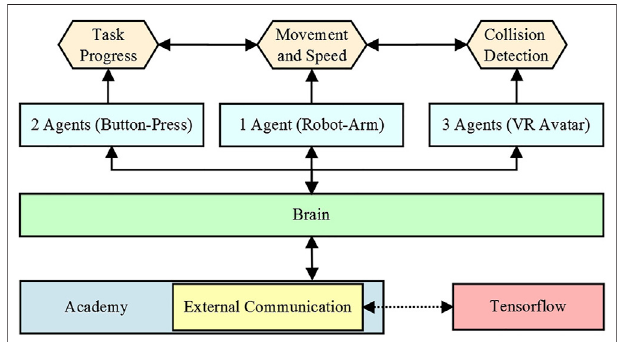
FIGURE 5 | The schematics of the ML-Agents framework consisted of three components, the agents, the brain, and the academy (Juliani et al., 2018). The agents monitored the states of the environment and assumed controlovertherobotarm.Determined bythebrain,therobotarmacted based on learned behavior stored in the